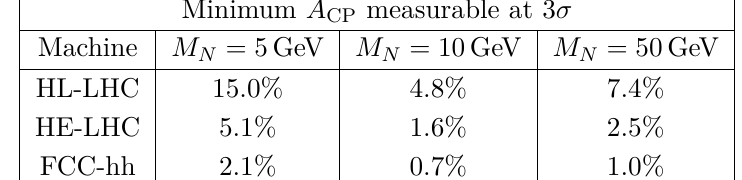
√ s = 14 TeV, peak L int = √ s = 100 TeV, peak L int =